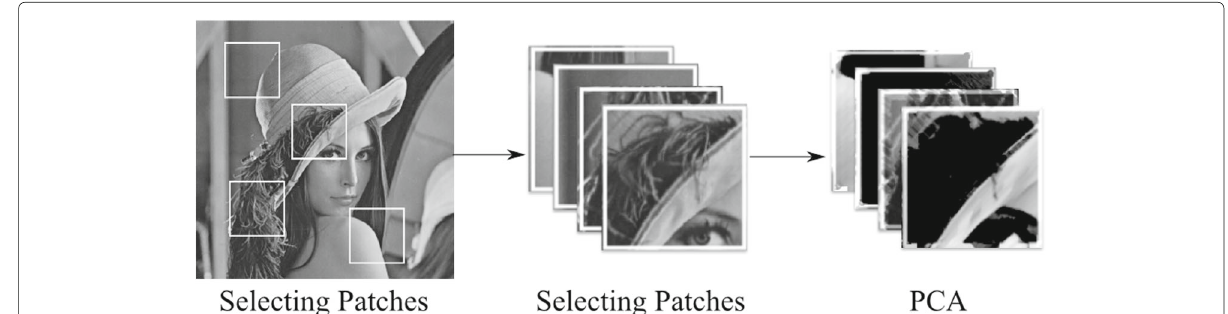
Fig. 5 Patches of PB-PCA method: extracting patches in PB-PCA method and grouping them before